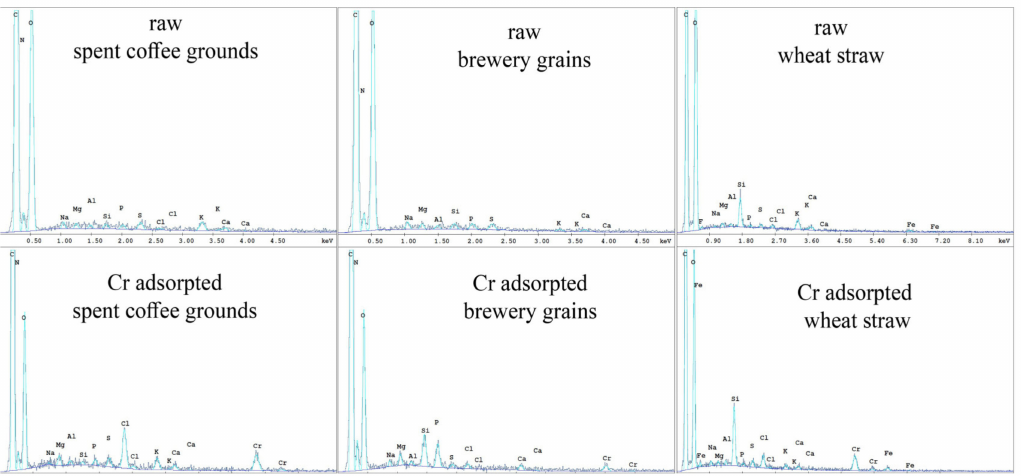
Figure 8. EDS spectra for biochars obtained at 400 ◦ C and after the chromium